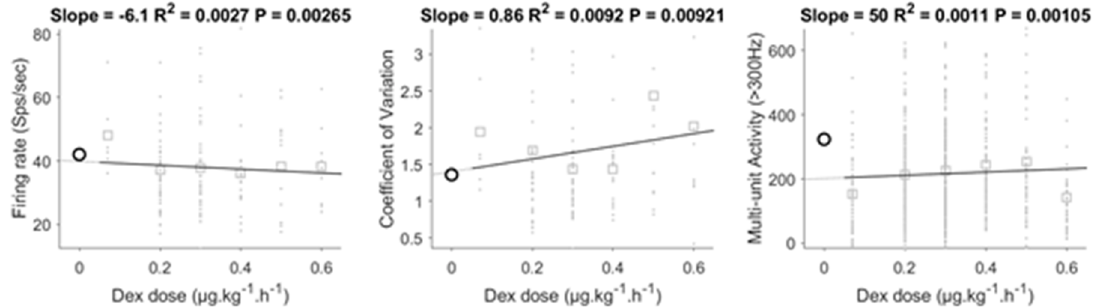
Figure 4. Correlation analysis on the dose of DEX for the electrophysiological measures. Correlations were significant. Data of the no PSA drug group is shown in black for comparison but was excluded from the regression analysis. DEX: dexmedetomidine.